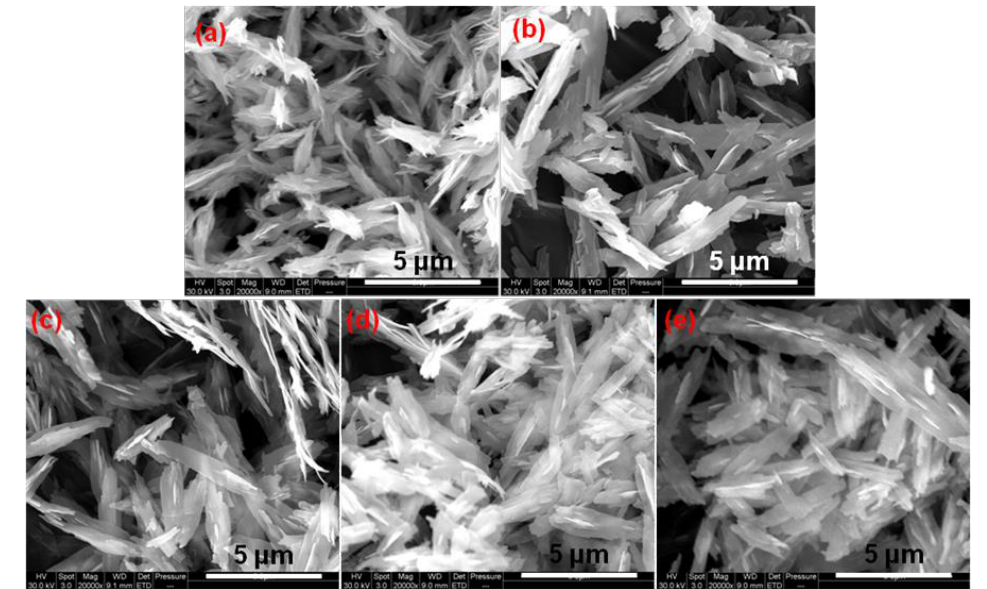
Figure 2. SEM images of the as-prepared CuO at 120 °C with different reaction times. ( a )2 h; ( b )4 h; ( c )8 h; ( d )12 h; and, ( e )16 h.